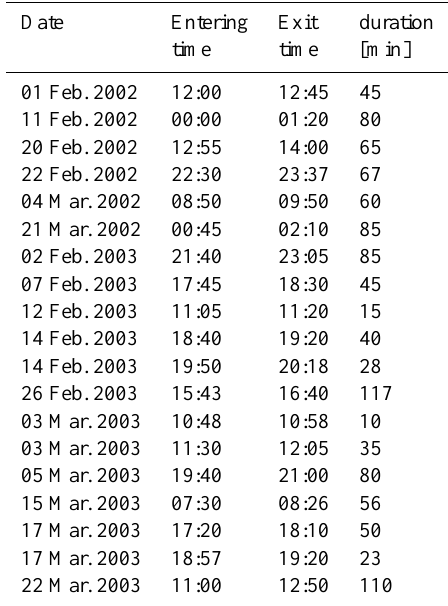
Table 2. A list of the times when Cluster 4 observed the high- latitude dayside